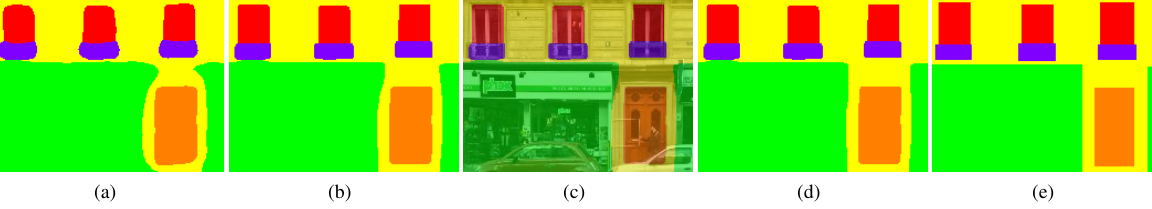
Table 4. Labeling results after optimization for various approaches on dataset ECP. Column (I-1) gives results for Auto-context (Jampani et al., 2015) after three iterations and (I-2) for Auto-context with CRF with an 8-connected neighborhood and pairwise Potts potentials. (II) presents the third layer of the three layered approach (Martinovi´c et al., 2012) for facade parsing and (III) ATLAS (Mathias et al., 2016), respectively. (IV) gives results for the DP optimization approach (Cohen et al., 2014). The end results of our method after 10 and 50 iterations are given by Ours-10 and Ours-50, respectively. Best results are marked in bold.